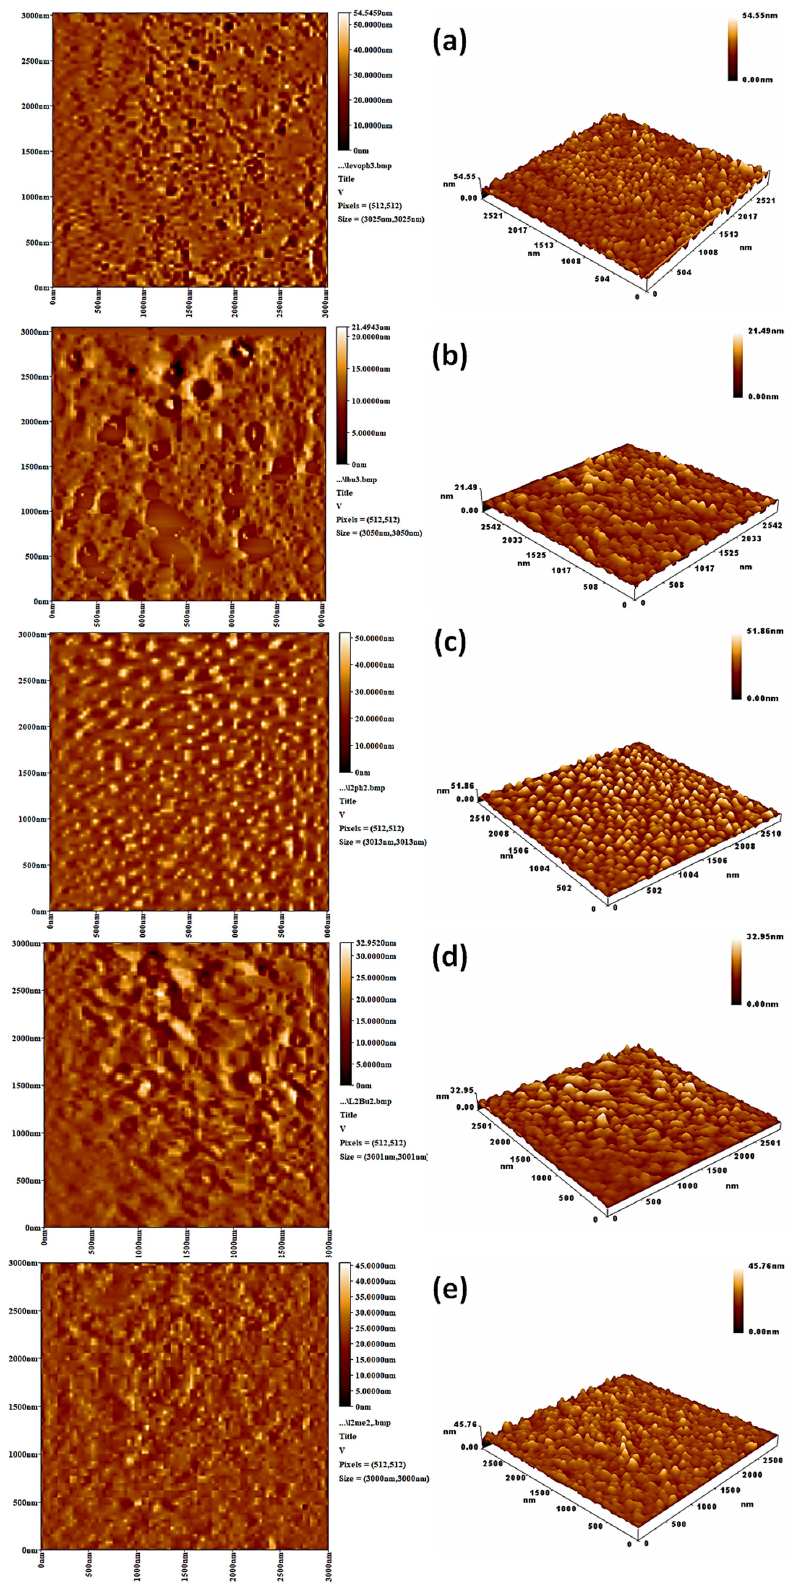
Figure 11. AFM images of irradiated PVC films ( a ): PVC/ 1 ( b ): PVC/ 2 , ( c ): PVC/ 3 , ( d ): PVC/ 4 , and ( e ): PVC/ 5